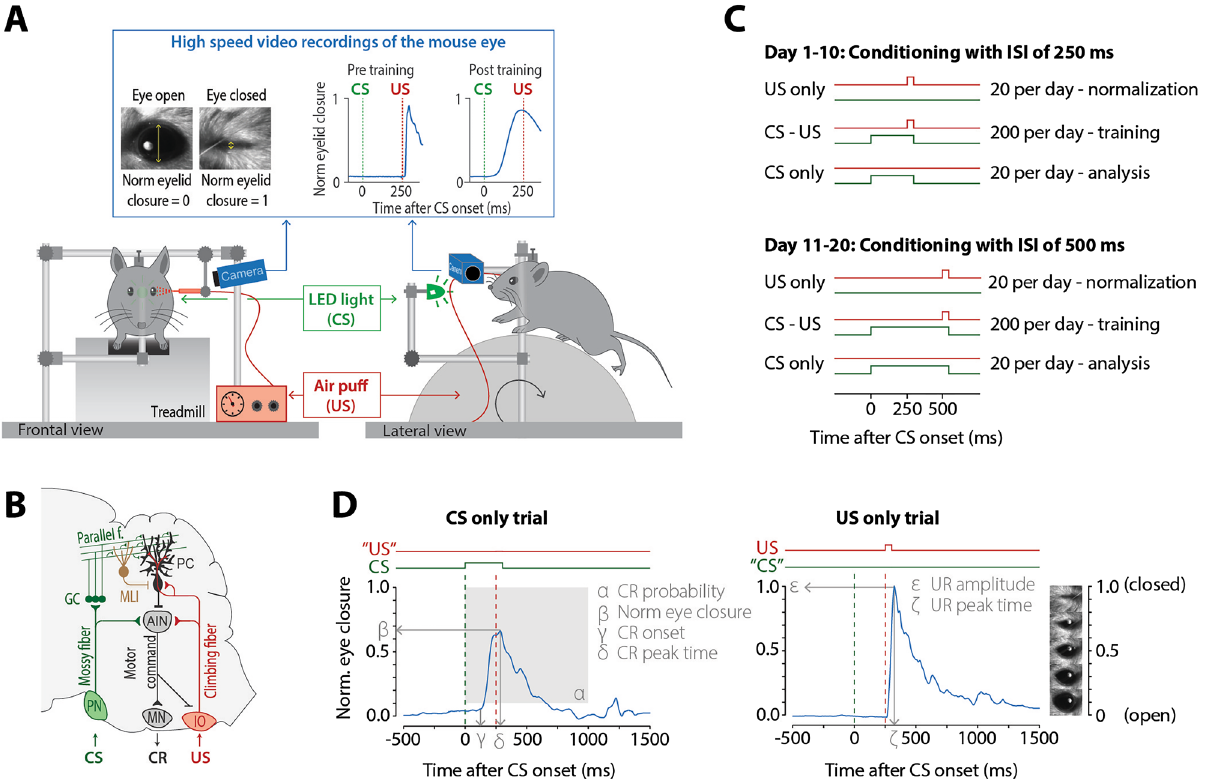
Figure 1. Eyeblink conditioning apparatus, training scheme, and neural circuits. ( A ) Mouse eyeblink- conditioning apparatus. Conditional stimulus (CS) is a green LED light and unconditional stimulus (US) is a mild air puff applied to the eye. Eyelid movements are measured using high-speed video recordings (350 fps). During the experiment, the animal is head-fixed, but able to move freely on a foam treadmill. ( B ) During Pavlovian EBC, memory formation takes place in PCs of defined areas of the cerebellar cortex. These PCs receive inputs from the mossy fiber–PF system, which conveys sensory CS signals (green) and input from a single CF, which transmits the instructive US signal (red). During the conditioning process, these PCs acquire a well-timed suppression of their simple spike firing in response to the CS, thereby temporarily disinhibiting the cerebellar nuclei, which drives the overt eyeblink CR. ( C ) Eyeblink conditioning training scheme. On each training day in each training phase, there are three types of trials: US only, CS–US paired, and CS only trials that are presented in a semi-randomized fashion. ( D ) Calculation of different eyeblink conditioning outcomes. AIN anterior interposed nucleus, CR conditioned response, CS conditional stimulus, GC granule cells, IO inferior olive, MLI molecular layer interneurons, MN motor neurons, PC Purkinje cell, PN pontine nuclei, UR unconditioned response, US unconditional